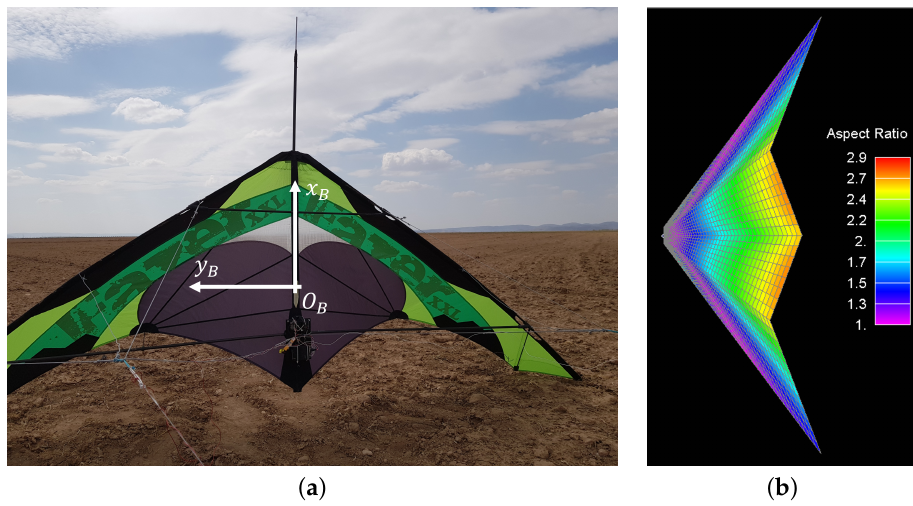
Figure 1. ( a ) shows the RFD kite (HQ Fazer XXL) during the experimental campaign. ( b ) displays the aerodynamic mesh of the VLM model. The color bar represents the aspect ratio of the mesh